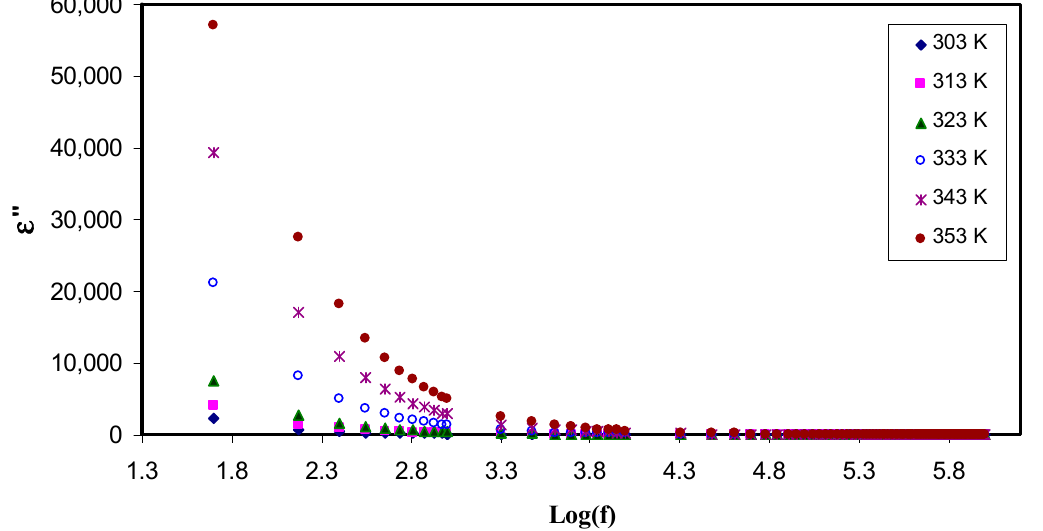
Figure 6. Constant( ε′ ) as a function of the logarithm of frequency ( f ) at different temperatures. It is obvious that the dielectric constant increases with increasing temperature at low frequency region due to electrode polarization effect.